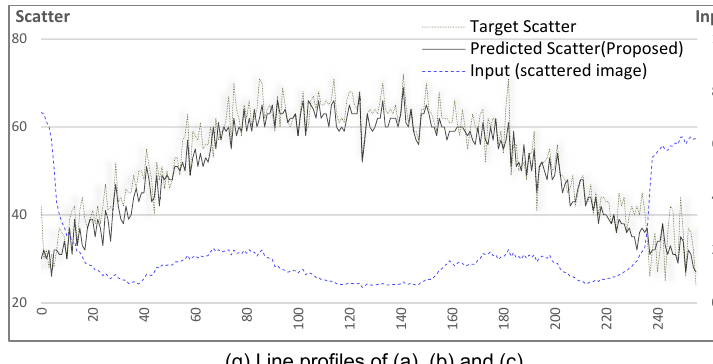
Figure 6. Predicted scatter after training.